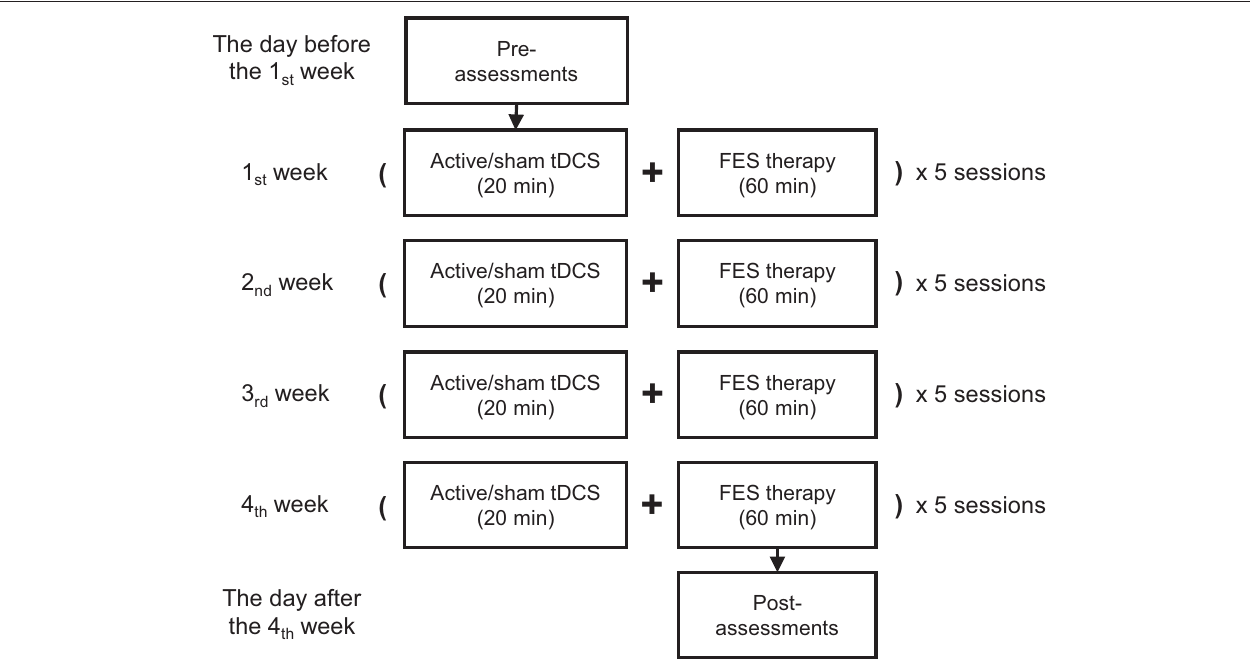
FIGURE 1 | The proposed protocol with 20 sessions involving both tDCS and FES therapy over 4 weeks. Each session was carried out on a workday during the intervention